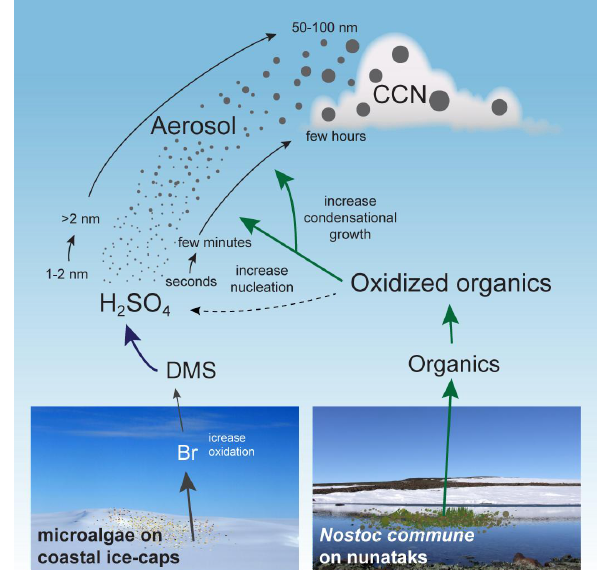
Fig. 17. Continental new particle formation in Antarctica: meltwater ponds that form during summertime hold lots of organics inside – including blue-green algae Nostoc commune . These ponds are found close to nunataks and blue-ice areas. The organics are oxidised in the atmosphere and increase locally the condensational growth of particles and can have an influence in the nucleation as well. The oxidised organics play a key role in growing the aerosols enough – up to 50–100nm in diameter – for them to have climatic effects. This growth takes only few hours, whereas with only sulphuric acid growing the particles, the timescale would be days and the particles would be scavenged from the atmosphere before reaching sufficient sizes. The bromine emissions from coastal ice caps, as suggested by Antony et al. (2010), increase the oxidation of DMS and can therefore increase the nucleation even at larger scale. The sources of DMS include ocean, algae in meltwater ponds and possibly microalgae in the snow.